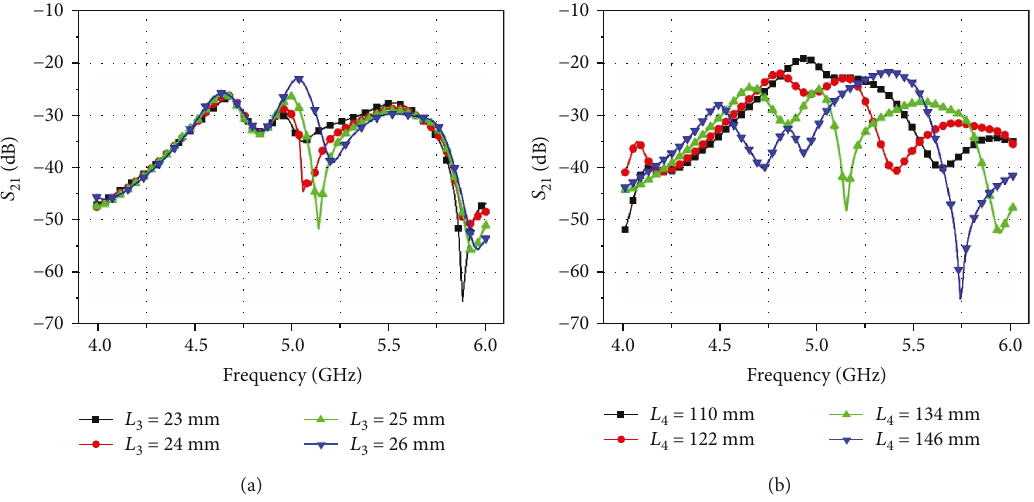
ff erent L 21 for di 3 . (b) Simulated